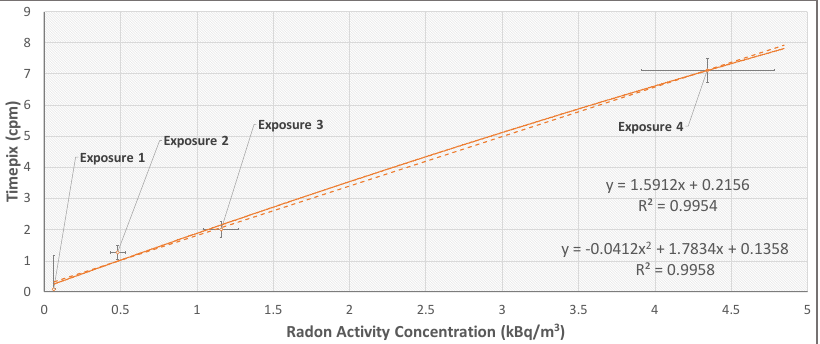
Figure 9. Linearity of the TimePix response. The trendlines equations are shown in figure, where the values of the coefficient R are also reported.